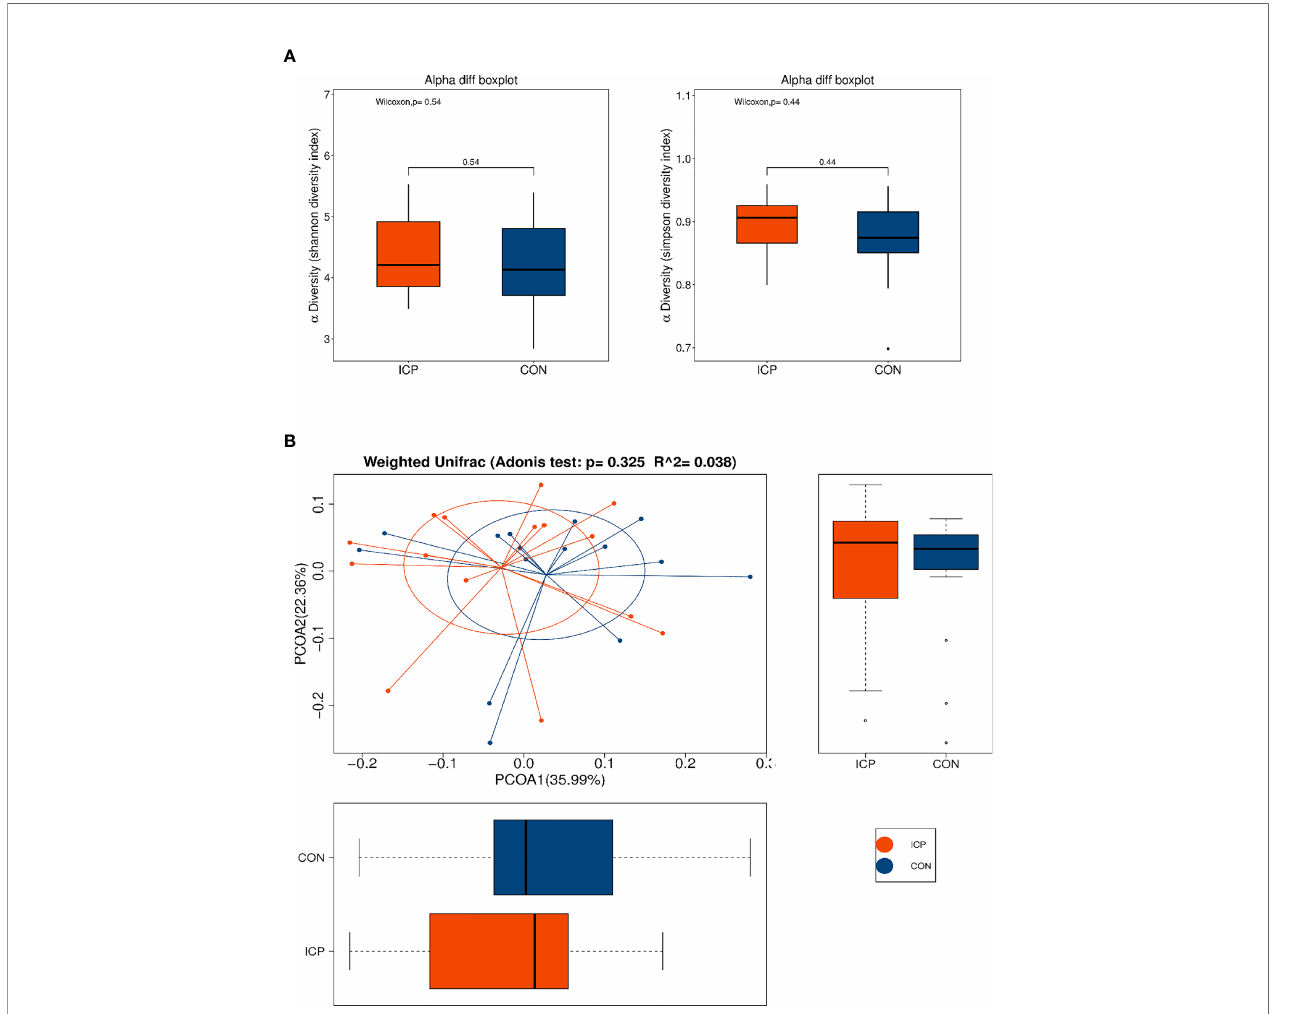
FIGURE 1 | a and b -diversity of fecal microbiota in patients with ICP and healthy control (CON) subjects. (A) Shannon and Simpson indices were used for a - diversity, and (B) Adonis analysis and a principle of coordinates analysis (PCoA) indices were used for b -diversity. Each box plot represents the median, interquartile range, minimum, and maximum values. No differences were detected either in the a -diversity or in the b -diversity indices of the gut microbiota between the two groups. Red represents the ICP group, and blue represents the healthy controls